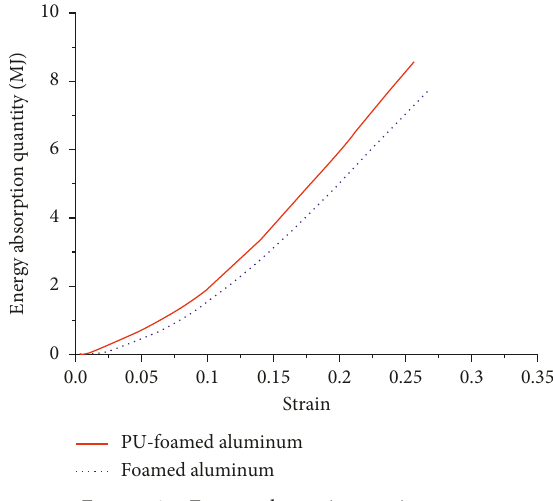
Figure 25: Energy absorption-strain curve.